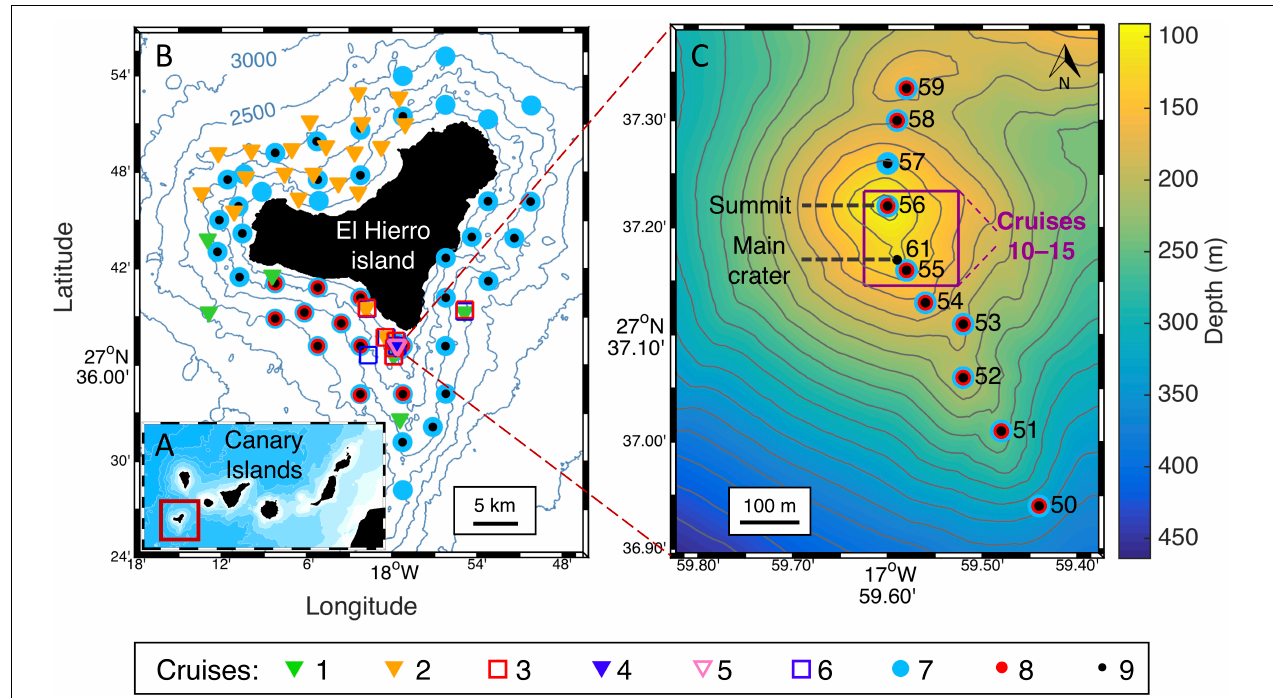
FIGURE 1 | Study location. (A) Map of the Canary Islands. (B) Map of El Hierro island with stations of vertical profiles carried out during cruises 1–9. (C) Bathymetry of the volcanic edifice and high-resolution transect of vertical profiles carried out during cruises 7–9 across the main cones. The squared region shows the zone where the tow-yo samples (cruises 10–14) and vent samples (cruise 15) were collected. All maps were generated using Matlab 8.5